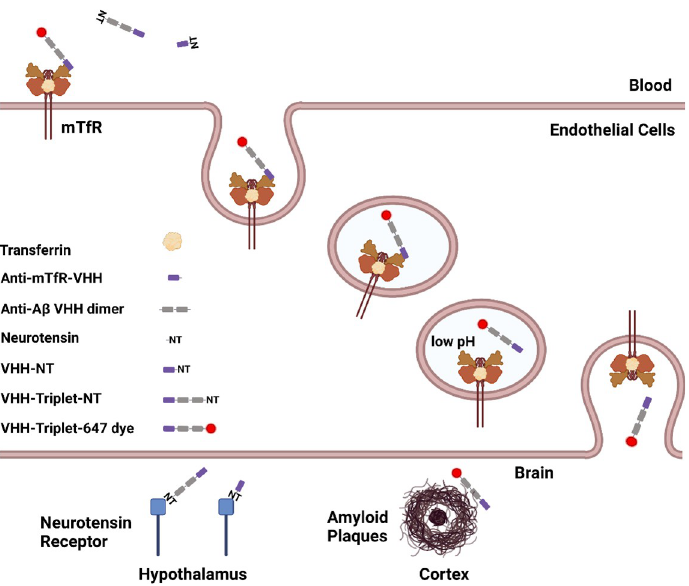
Fig 1. Schematic of the modular system for VHH-mediated BBB transcytosis and target engagement. Module 1: anti-mTfR VHH for RMT across BBB. Module 2: neurotensin peptide (NT) for rapid assessment of in vivo target engagement via measurement of hypothermia. Module 3: anti-A β VHH dimer for disease-relevant target engagement in brain parenchyma. Module 4: 647 dye for visualization of VHH constructs in situ. The anti-mTfR VHH was combined with NT for anti-mTfR VHH screening through monitoring hypothermia effect. The anti-mTfR VHH were combined with VHH dimer and NT or 647 to test the effect of anti-mTfR VHH together with other components of the module. This schematic figure also shows the TfR mediated transcytosis across BBB. The anti-mTfR VHH conjugates binds to TfR on the endothelial cells which comprise a major portion of the BBB. Then the TfR-VHH complex is endocytosed across the endothelial cells in the endosomes. VHHs dissociate from the TfR-VHH complex with decreased pH level in endosome and are released on the brain side of the BBB. There were two different targets in the brain parenchyma in this study, the NT receptor in hypothalamus and amyloid plaques in cortex and hippocampus. (Figure generated using